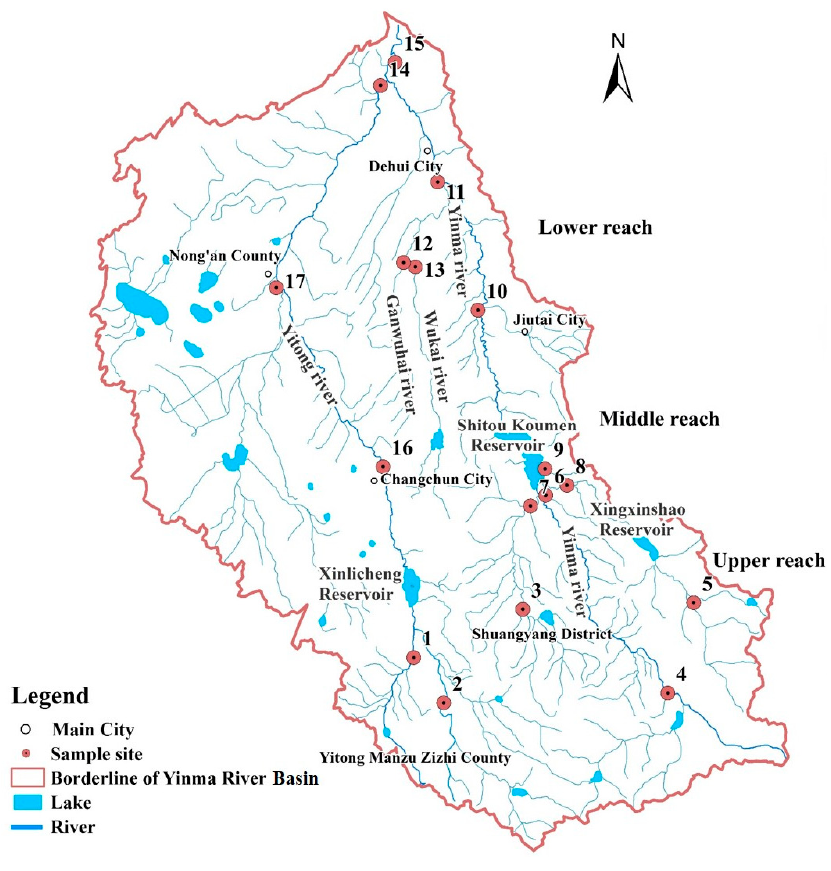
Figure 1. Sampling sites of the Yinma River Basin.